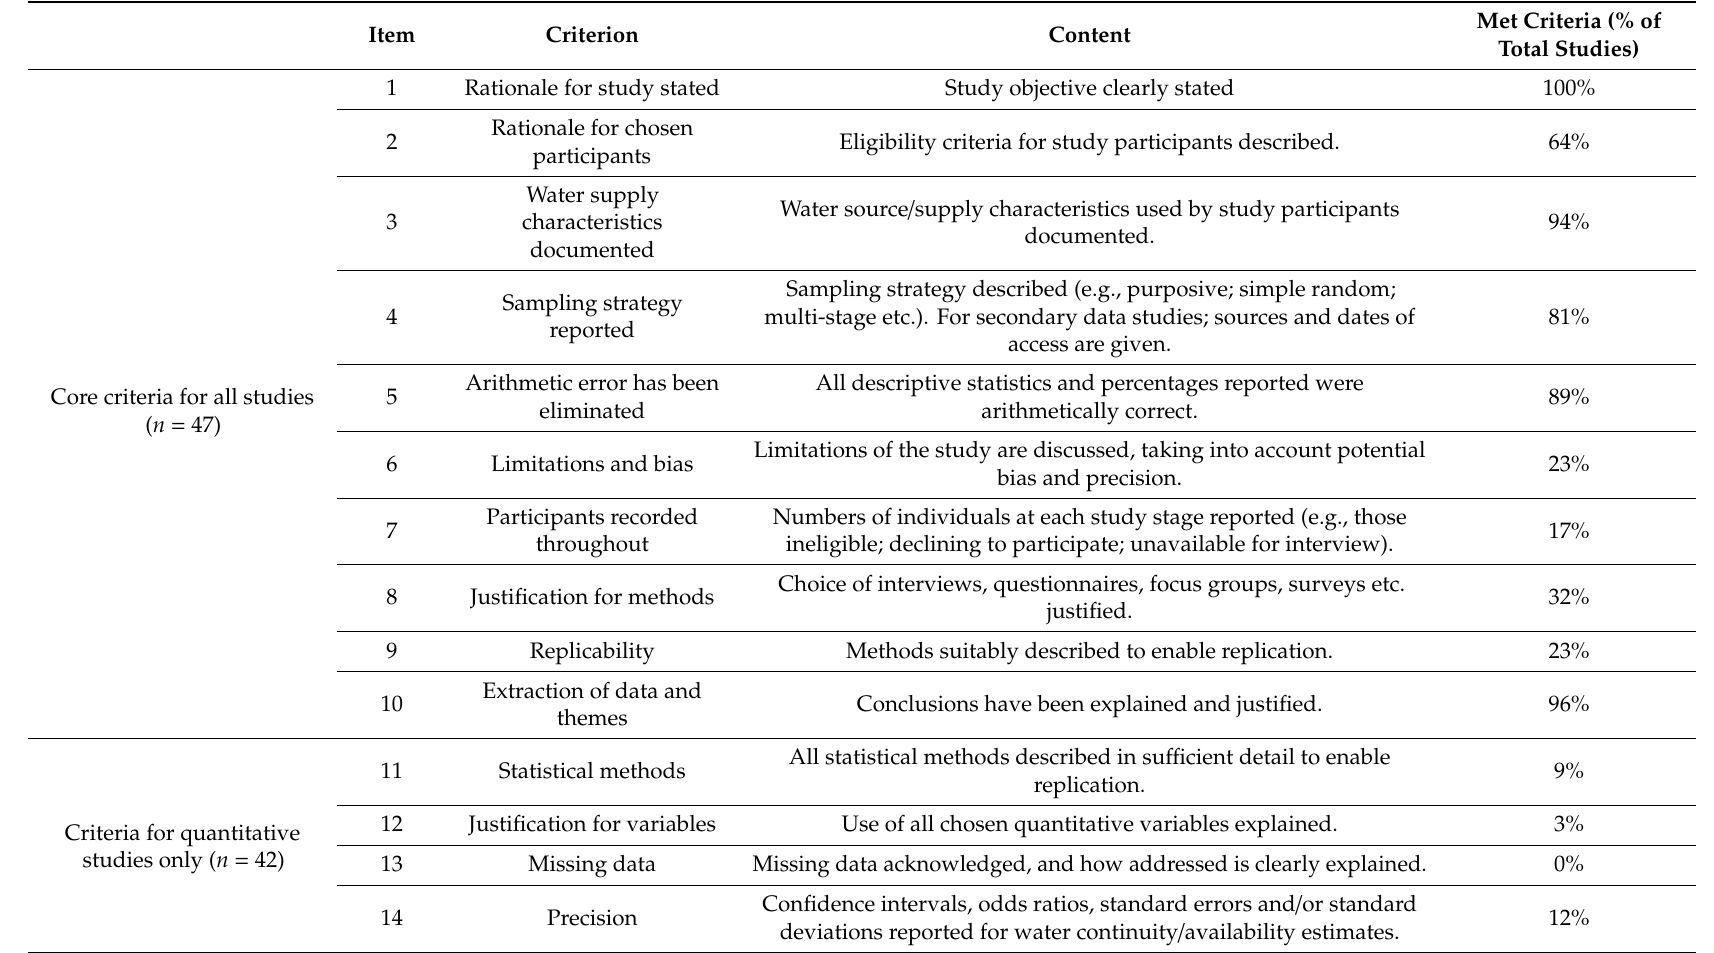
Table 3. Assessment of study